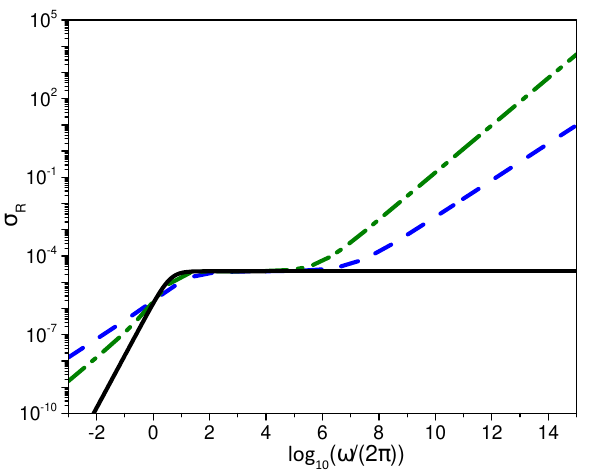
Figure 2. Electrical conductivity, σ R vs. ω for different values of γ as in Figure 1, where σ R = ( S / d ) σ